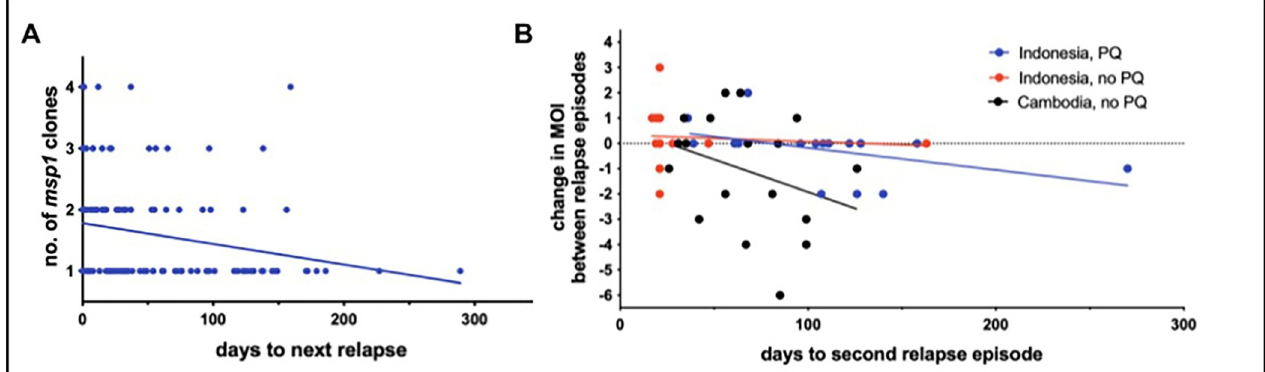
Fig 2. Decreased clonal burden in relapses over time. (A) Among 127 relapses in returning Indonesian soldiers, the number of pvmsp1 clones detected at relapse decreased over time, as measured by days since enrollment one month after arriving to Java (slope = -0.003, p = 0.01). (B) Among 33 Indonesian soldiers with dual relapse, the multiplicity of infection (MOI) decreased between the first and second relapse episode, driven by those who received primaquine at their first relapse (depicted in blue) (slope = -.007, p = 0.03). Similarly, relapses in 18 Cambodian soldiers determined genotypically to have relapse [13] suggest a decrease in MOI from their initial vivax episode to relapse (slope = -0.03, p = 0.20). Lines of best fit were determined by linear regression.